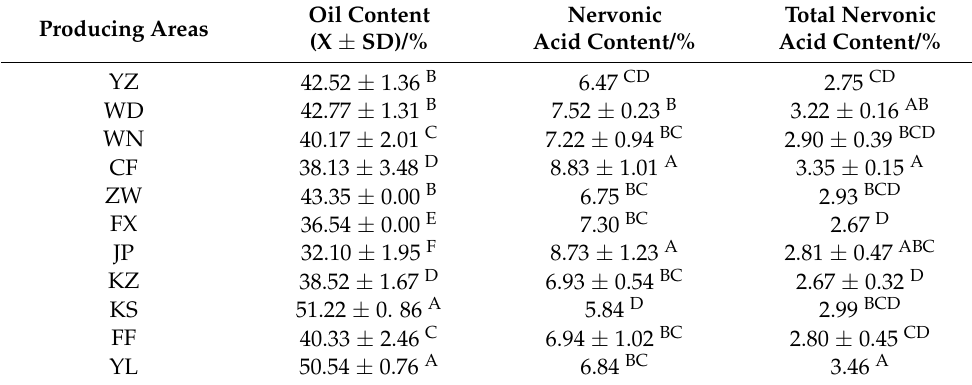
Table 4. Kernel oil content, the relative content of nervonic acid and total nervonic acid in kernel oil of A. truncatum from different producing areas.